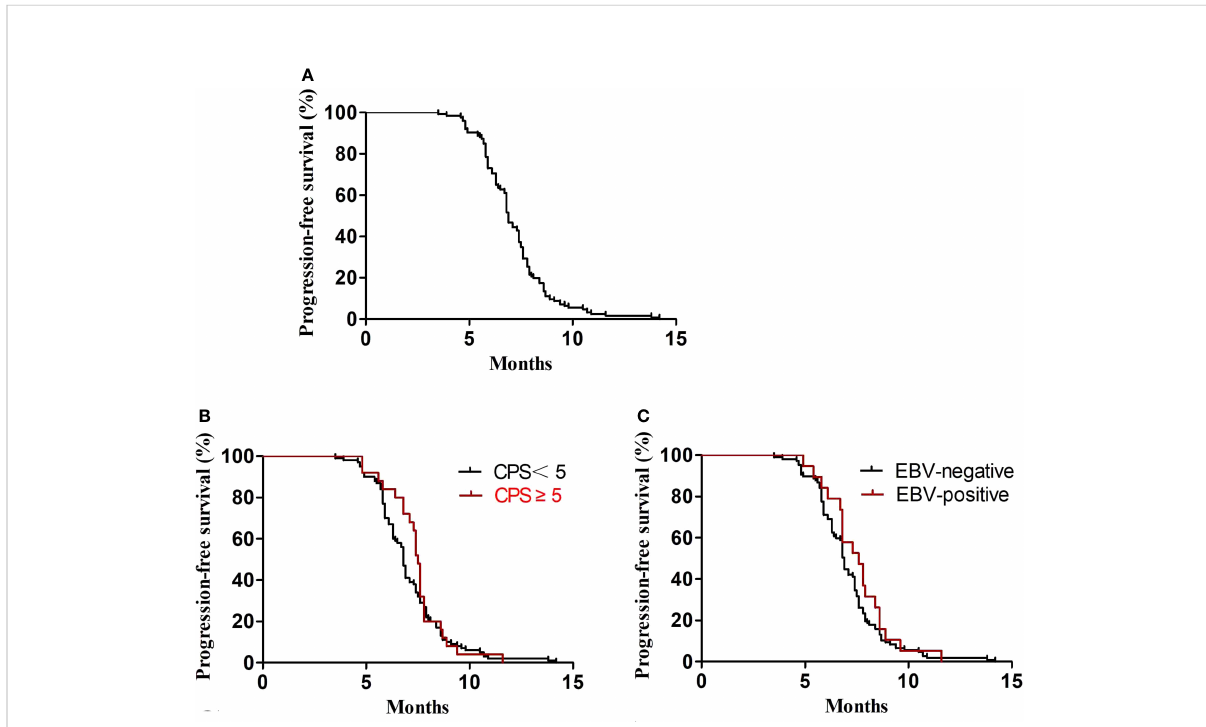
FIGURE 1 PFS1. (A) Kaplan – Meier plots for PFS1 in the fi rst-line treatment. (B) PFS1 according to PD-L1 (P = 0.43). (C) PFS1 according to EBV (P =